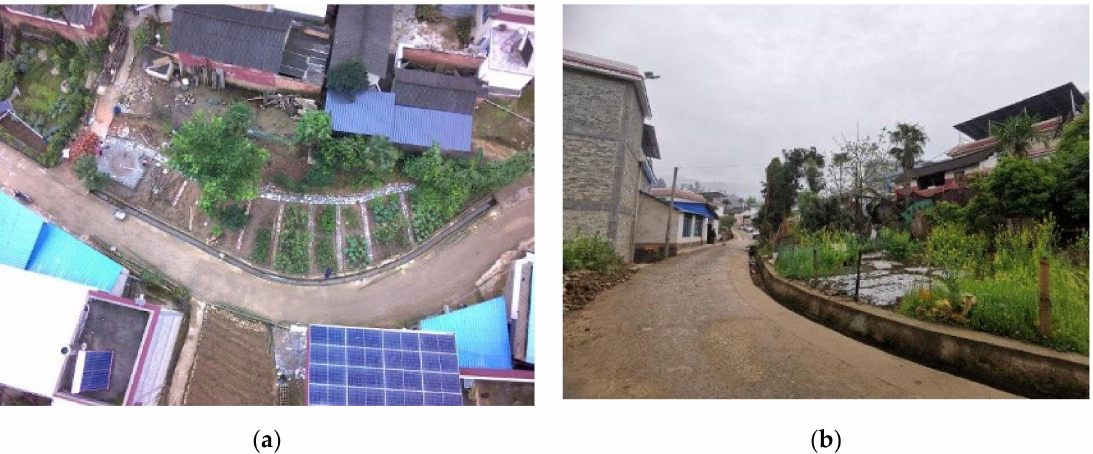
Figure 3. The sample farmyards before rebuilding and beatification in Hongtang Village. ( a ) The farmyard site; ( b ) the surrounding environment. Source: the authors, taken in August